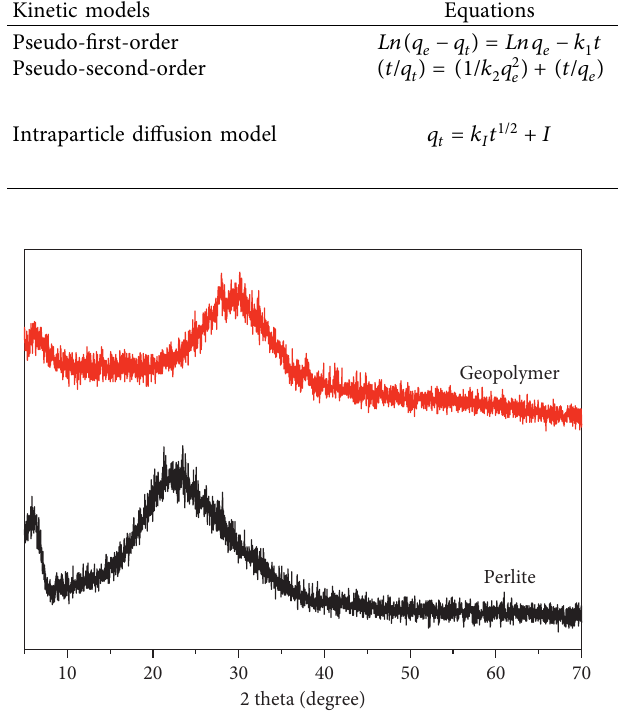
Figure 1: XRD analysis of perlite and the obtained geopolymer.